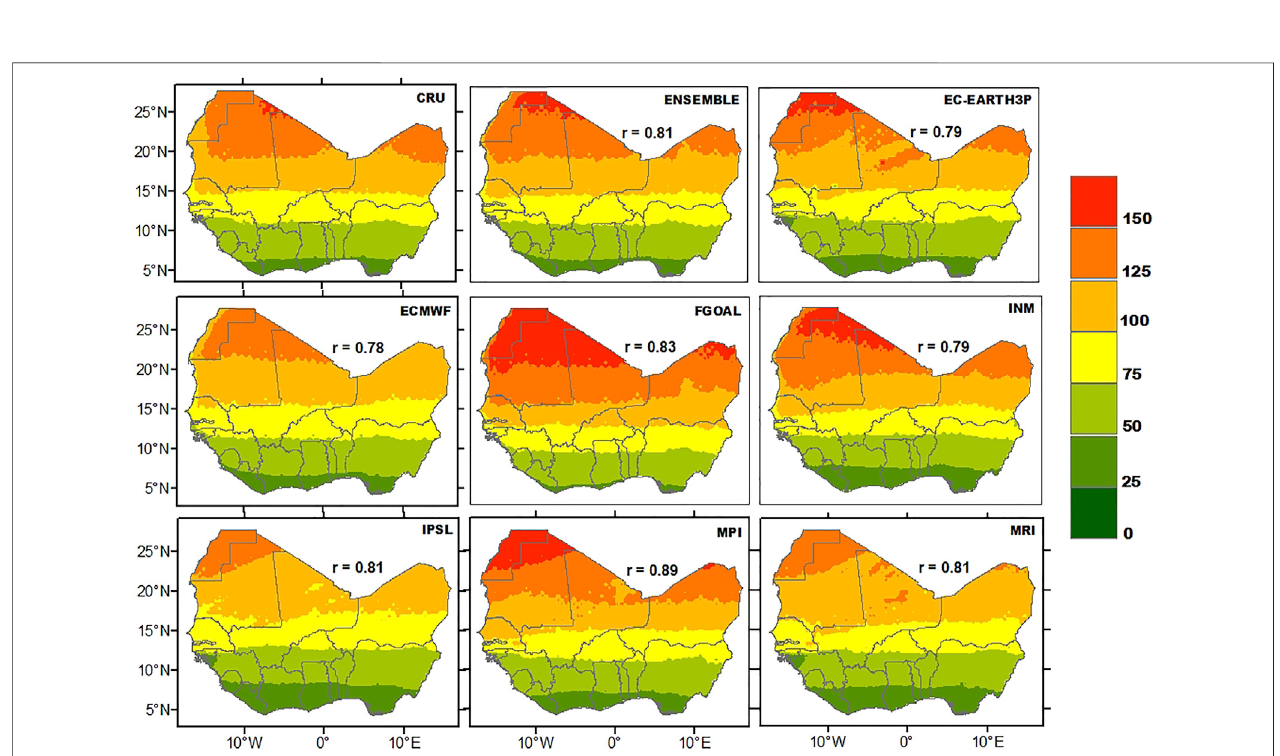
FIGURE 3 | Observed and simulated climatological distribution of potential evapotranspiration (PET) over West Africa during 1985 – 2014. r is the Pearson pattern correlation between CRU and each HighResMIP simulation.